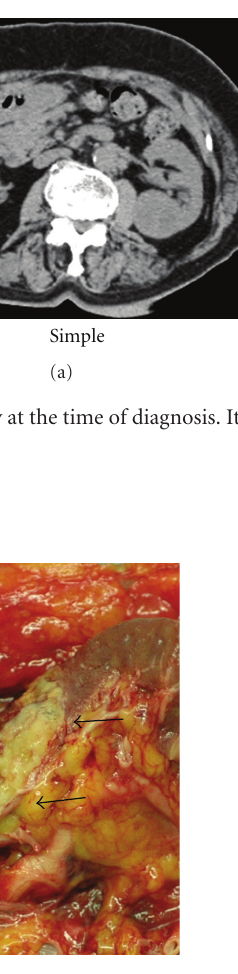
Figure 2: A gross pathologic specimen. Sectioning revealed a light yellow well-circumscribed mass in the middle portion of the kidney, measuring 3 . 5 × 3 . 8 cm. The tumor contained the hemorrhage or necrosis at inside.